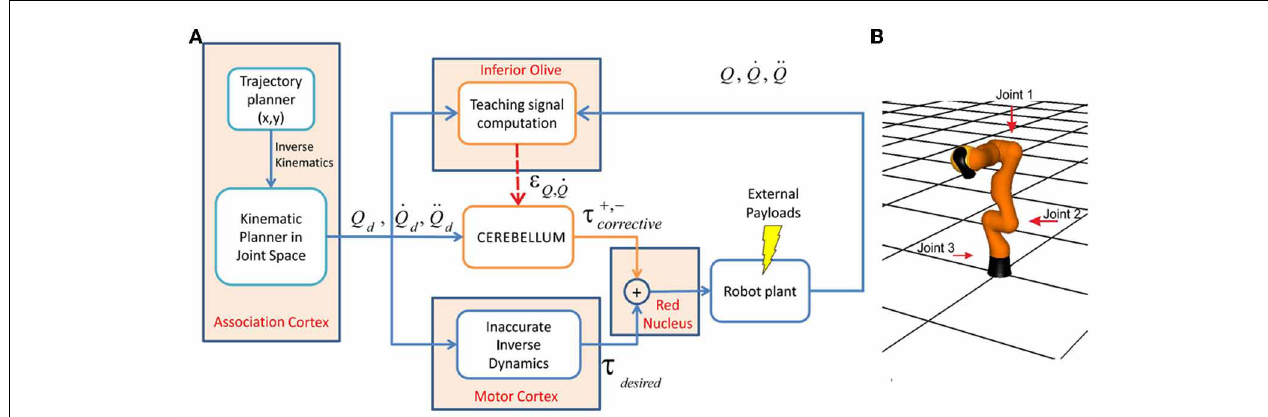
FIGURE 4 | Control scheme and robotic arm. (A) Essential control loop used for simulated manipulation tasks. The association cortex generates the desired trajectory (in terms of position, velocity, and acceleration) in body coordinates and the corresponding command signal is transmitted to both the motor cortex and to the cerebellum through the MFs. In the motor cortex command torques are calculated using an inverse dynamic arm model. The cerebellum generates corrective torques compensating for deviations from target trajectory (error) caused by the dynamic interaction of the arm with the